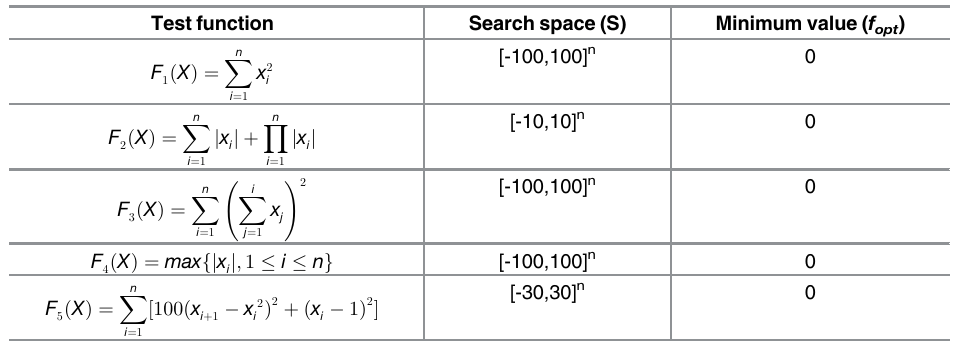
Table 2. Multimodal benchmark